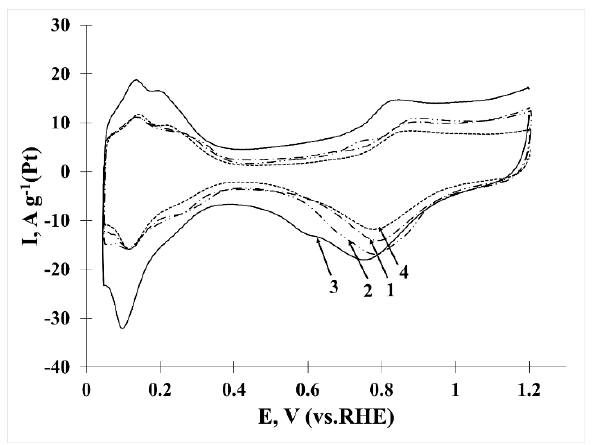
Figure 6. Cyclic voltammograms (2nd cycle). Electrolyte—1 M HClO 4 , Ar atmosphere. The scanning speed of the potential is 20 mVs − 1 : 1—PCC1; 2—PCC2; 3—Pt/C (JM20); 4—Pt/C (JM40). Table 3. Parameters characterizing the electrochemical behavior of